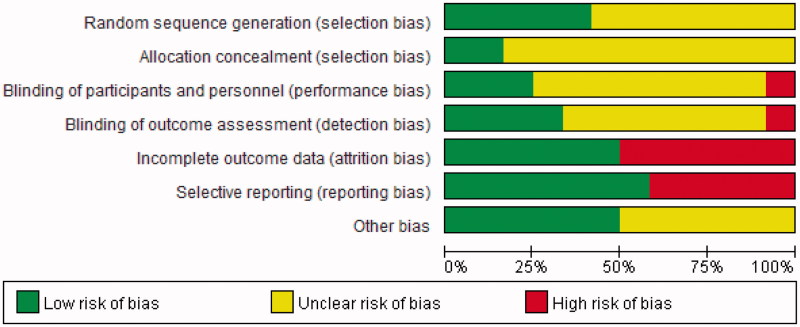
Risk of bias graph.